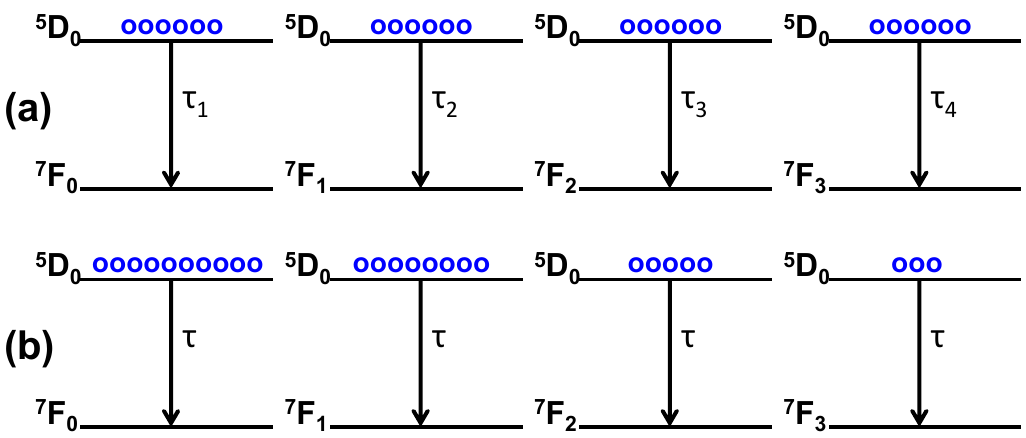
Figure 8. Diagrams for the decay rates of BaZrO 3 :Eu 0.025 phosphors. ( a ) With same quantity N and different decay time τ i ; ( b ) With different quantity N i and same decay time τ .